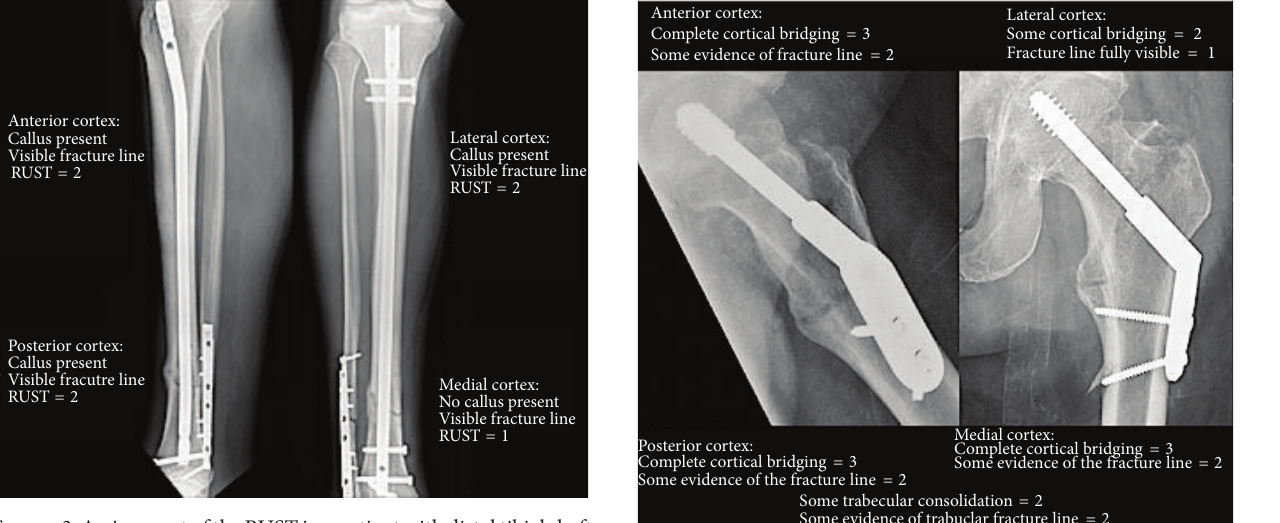
Figure3:AssignmentoftheRUSTinapatientwithdistaltibialshaft fracture at 3 months postoperatively. Overall RUST = 7. Table 1: Individual cortex score based on radiographic findings. These scores are added to calculate the RUST [16].